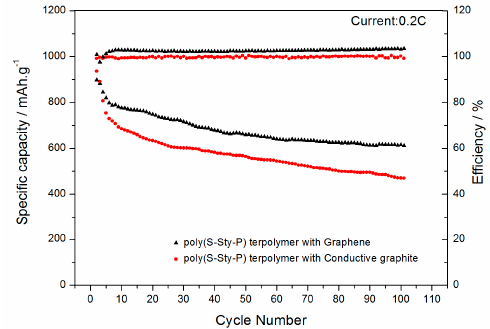
Figure 11. The cycle performance of poly(S-Sty-P) terpolymer @ CCB battery and poly(S-Sty-P) terpolymer @ GF battery.